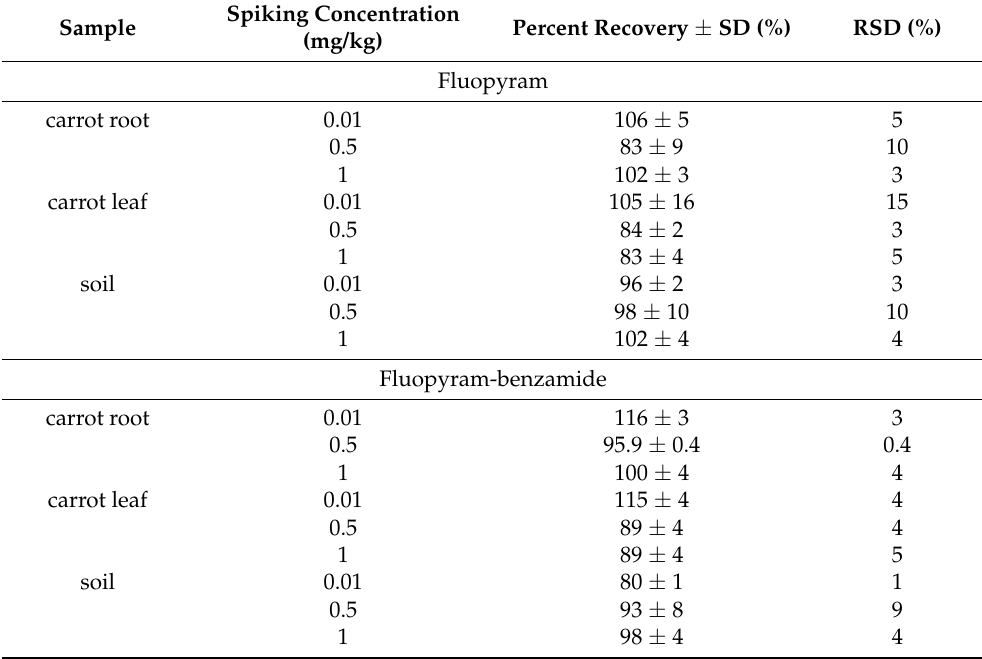
Table 1. Recovery and precision of fluopyram and fluopyram benzamide from carrots and soils measured by LC-QQQ-MS/MS.